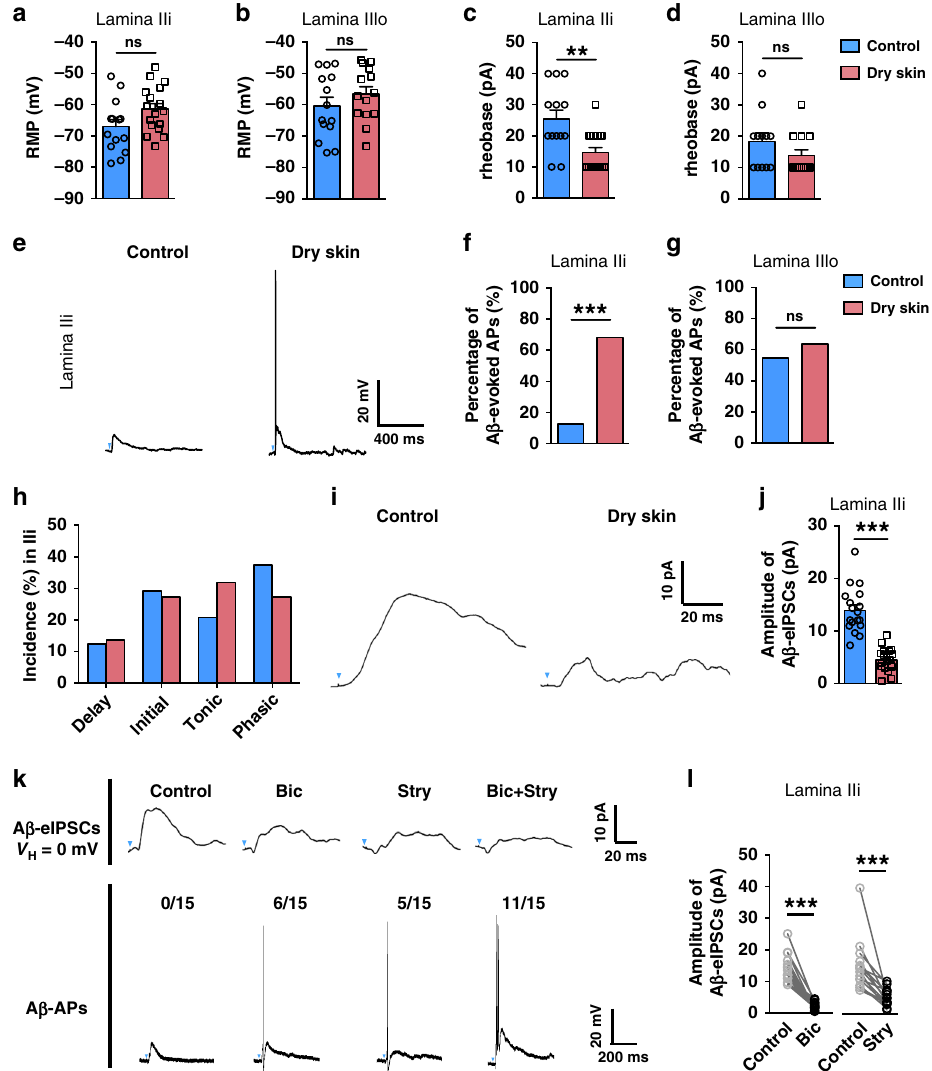
Fig. 8 Increased excitability of Tac2 tdTom neurons of dry skin mice. a – d Resting membrane potential (RMP) ( a , b ) and the rheobase of action potential ( c , d ) for Tac2 tdTom neurons in lamina IIi ( a , c) and lamina IIIo ( b , d ). Control: n = 14 neurons in a , b , 13 neurons in c and 12 neurons in d . Dry skin: n = 17 neurons in a , c , 14 neurons in b and 13 neurons in d . Two-tailed Mann – Whitney test. ** p = 0.0041, ns not signi fi cant. Data were from three mice per group. e Representative traces for A β -evoked APs in Tac2 tdTom neurons in laminae IIi of control mice (left) and dry skin mice (right). f , g Percentage of A β -evoked APs in Tac2 tdTom neurons in laminae IIi ( f ) and IIIo ( g ) of control and dry skin mice, respectively. Control: n = 24 neurons in f , n = 11 neurons in g ; dry skin: n = 22 neurons in f , n = 11 neurons in g , Chi-square test, *** p = 0.0001, ns not signi fi cant. Data from three mice per group. h Firing patterns of Tac2 tdTom neurons in control mice ( n = 24 neurons) and dry skin mice ( n = 22 neurons). Data from fi ve mice per group. i Representative traces for A β -eIPSCs in Tac2 tdTom neurons in lamina IIi of control mice (left) and dry skin mice (right). j The amplitude of A β -eIPSCs on Tac2 tdTom neurons in lamina IIi of control mice and dry skin mice. *** p = 0.00001, two-tailed unpaired Student ’ s t- test, n = 18 neurons per group. k Representative traces of A β -eIPSCs on Tac2 tdTom neurons in lamina IIi before (control) and after bath application of bicuculline (Bic) and/or strychnine (Stry). Blue arrows indicate stimulation artifacts. Data were from three mice per group. l The amplitude of A β -eIPSCs on lamina IIi Tac2 tdTom neurons before (control) and after bath application of bicuculline or strychnine. *** p = 0.0001, two-tailed paired Student ’ s t- test, n = 15 neurons per group. Data are presented as means ± s.e.m. Error bars represent s.e.m. Source data are provided as a Source Data fi